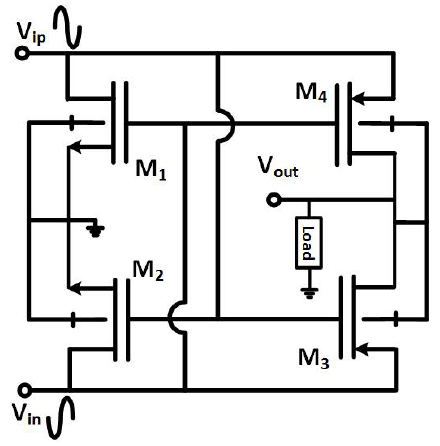
Figure 2: Differential drive (Cross-connected) CMOS rectifier